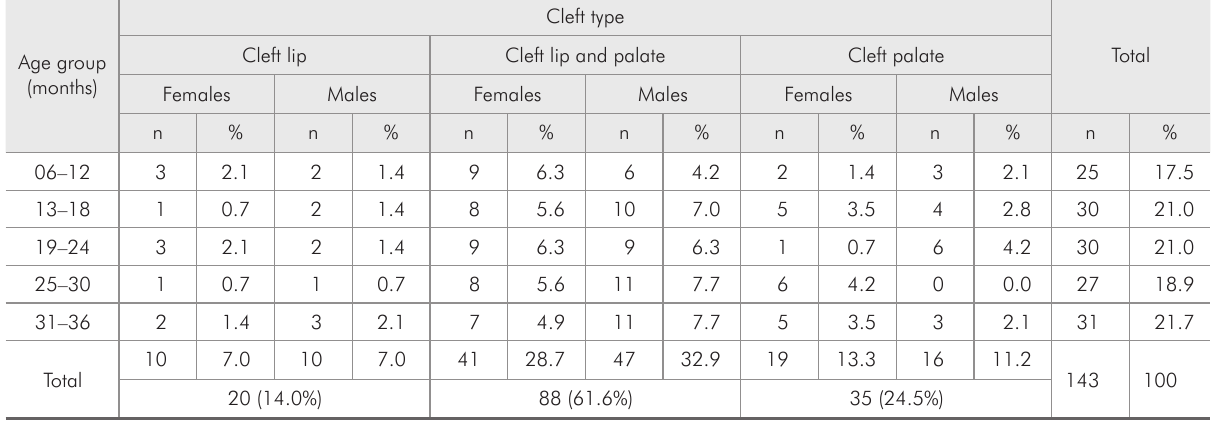
Table 1 - Sample distribution according to cleft type, gender and age, expressed in absolute numbers and percentages.